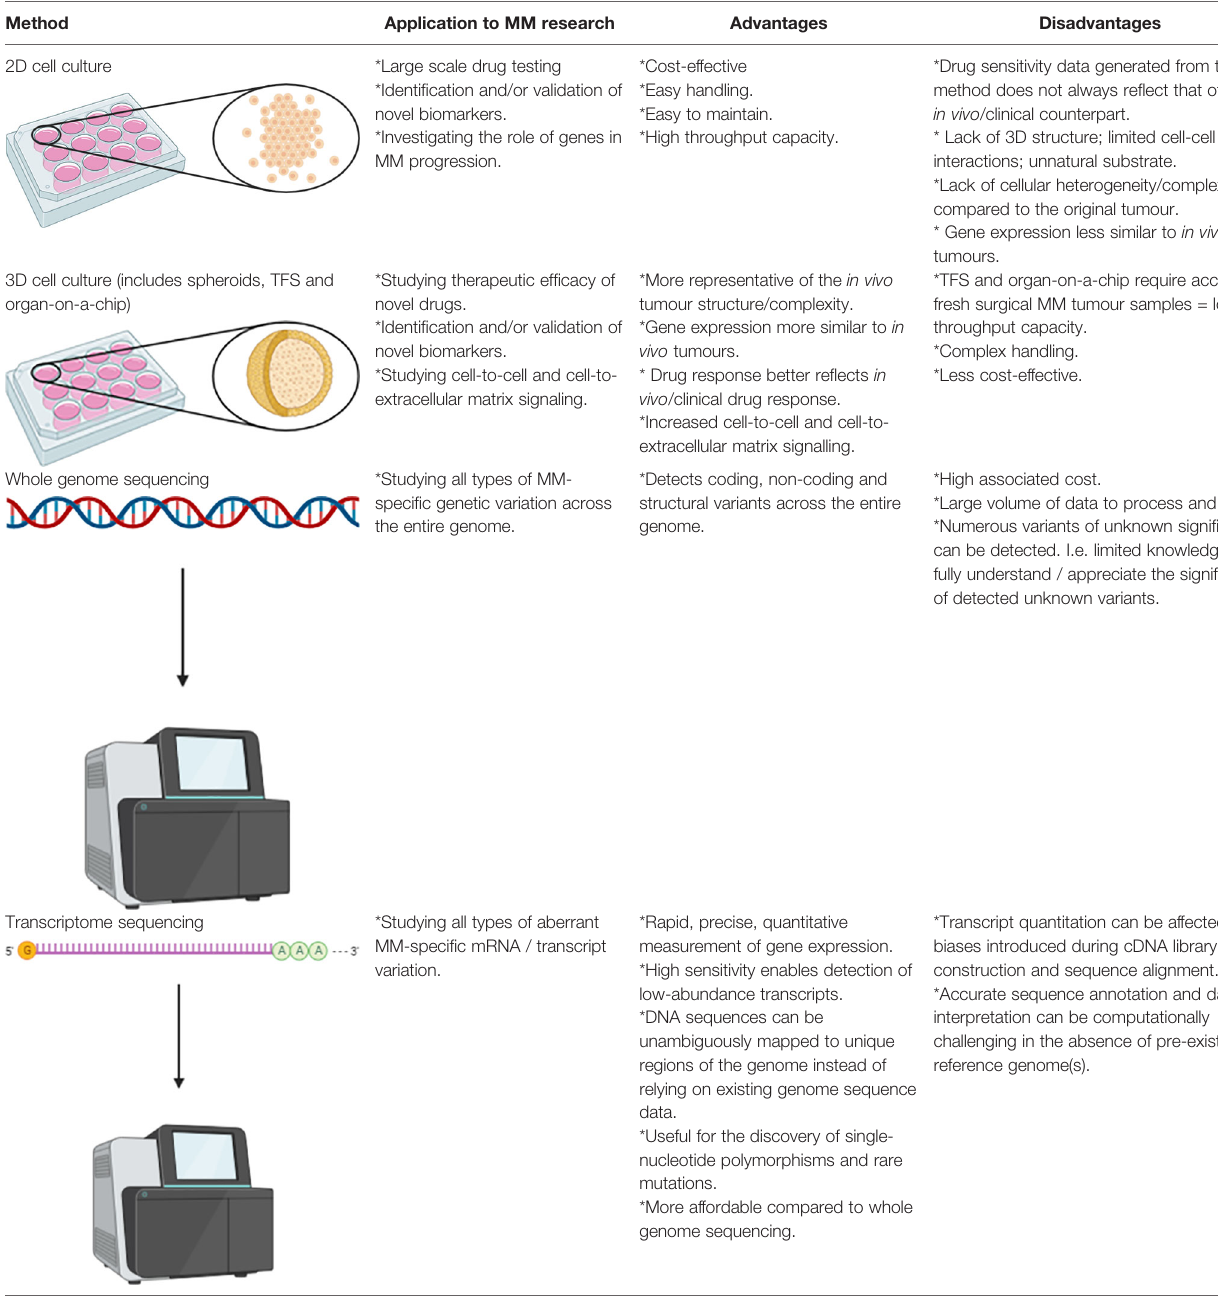
TABLE 2 | Summary of the applications of in vitro 2D and 3D cell culture methods for MM research and their main advantages and